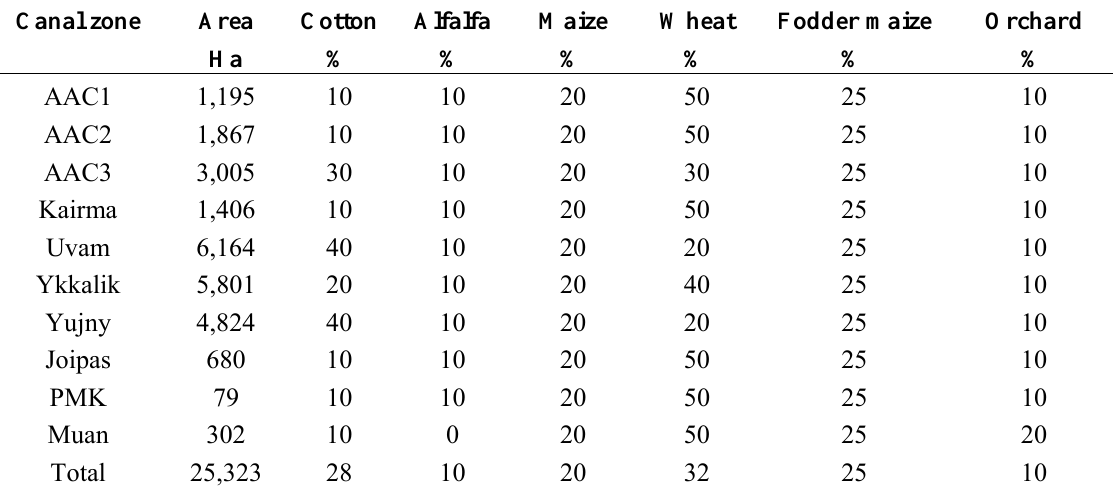
Table 3. Cropping pattern in the Akbura River basin.